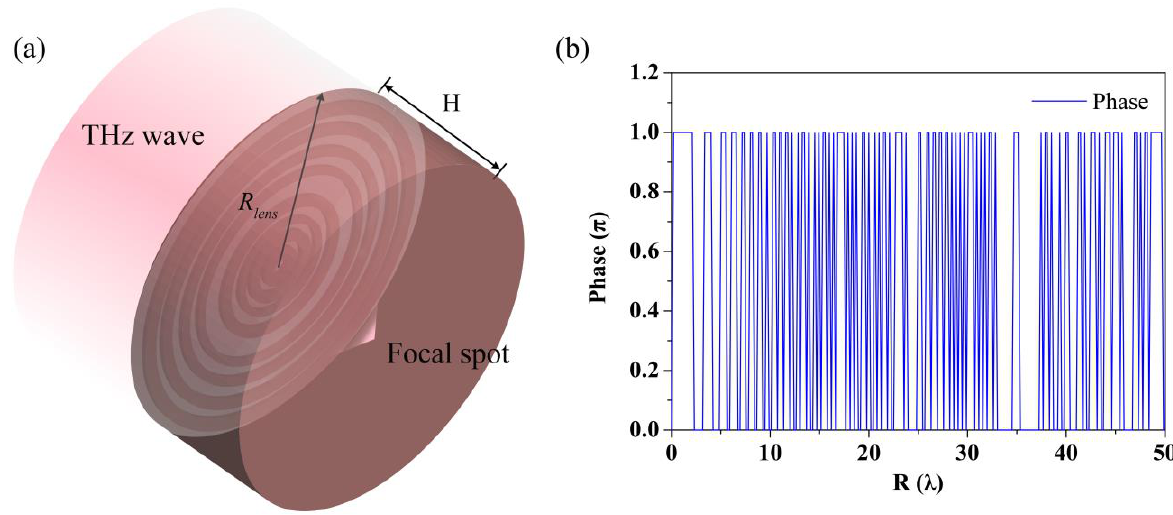
Figure 1. ( a ) Schematic diagram of solid immersion lens with beam focused in air. ( b ) Binary phase distribution of the solid immersion lens.